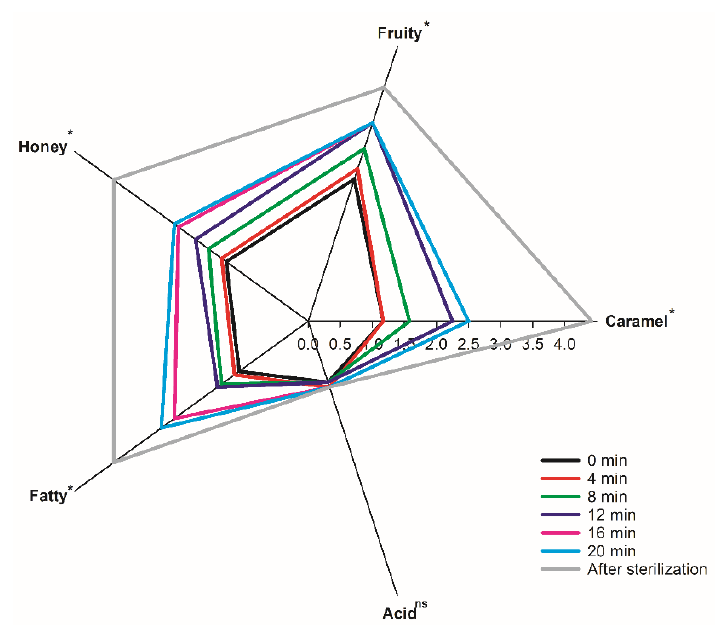
Figure 1. Flavor profiles for the coconut jams (0, 4, 8, 12, 16, 20 min, and after sterilization). The treatments were evaluated in triplicate by 10 panelists ( n = 30). Asterisks and “ns” indicate significant (* p ≤ 0.05) differences and no significant differences of means, respectively.